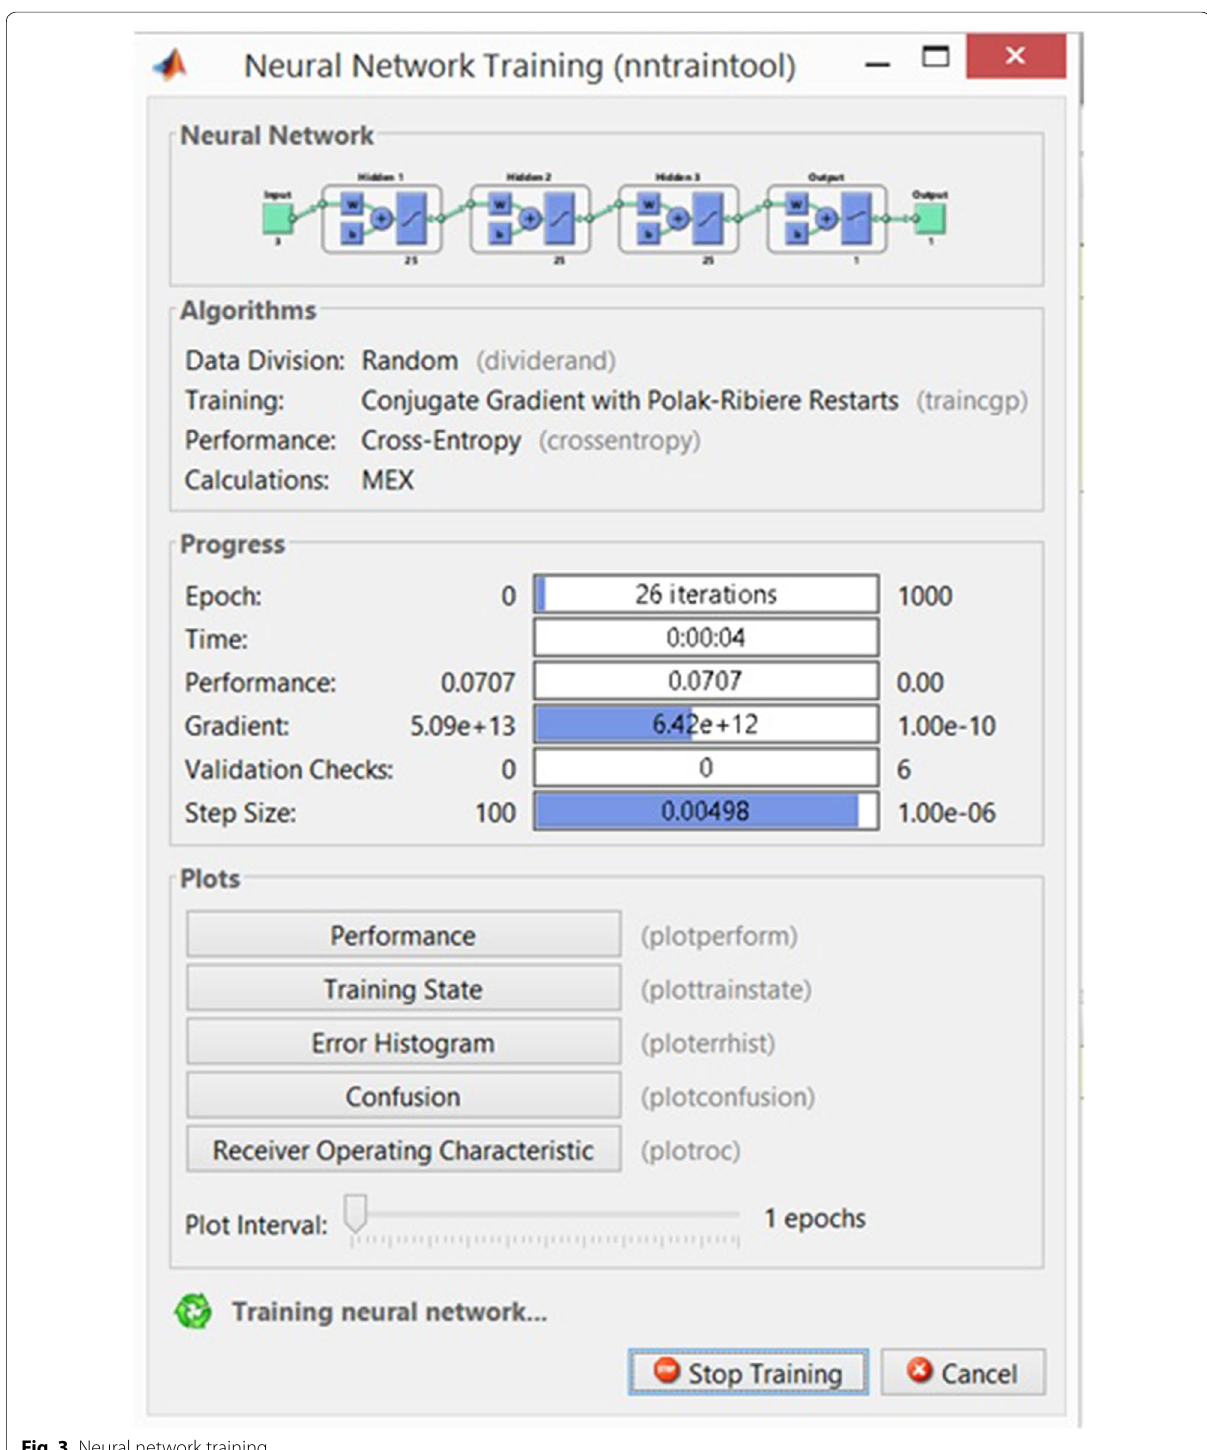
Fig. 3 Neural network